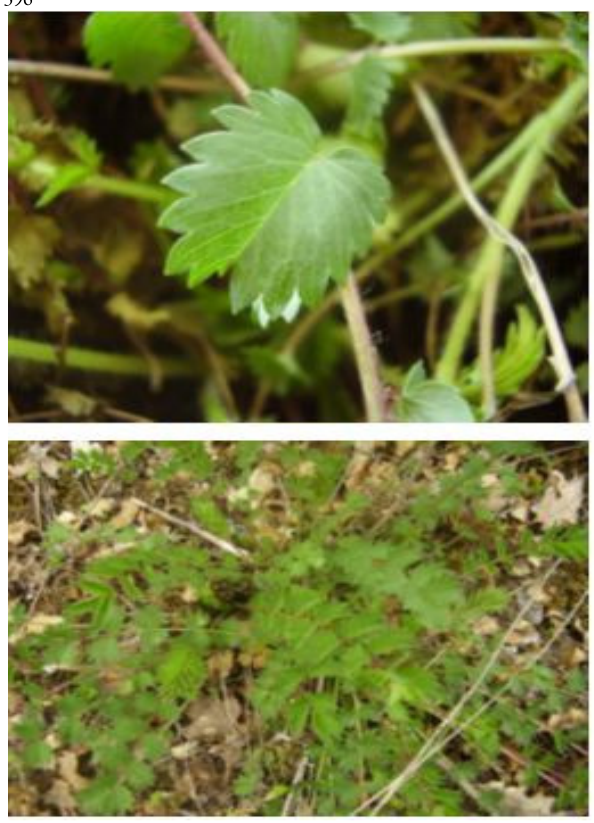
Fig. 1. Plant and leaves of small burnet ( Sanguisorba minor Scop.)